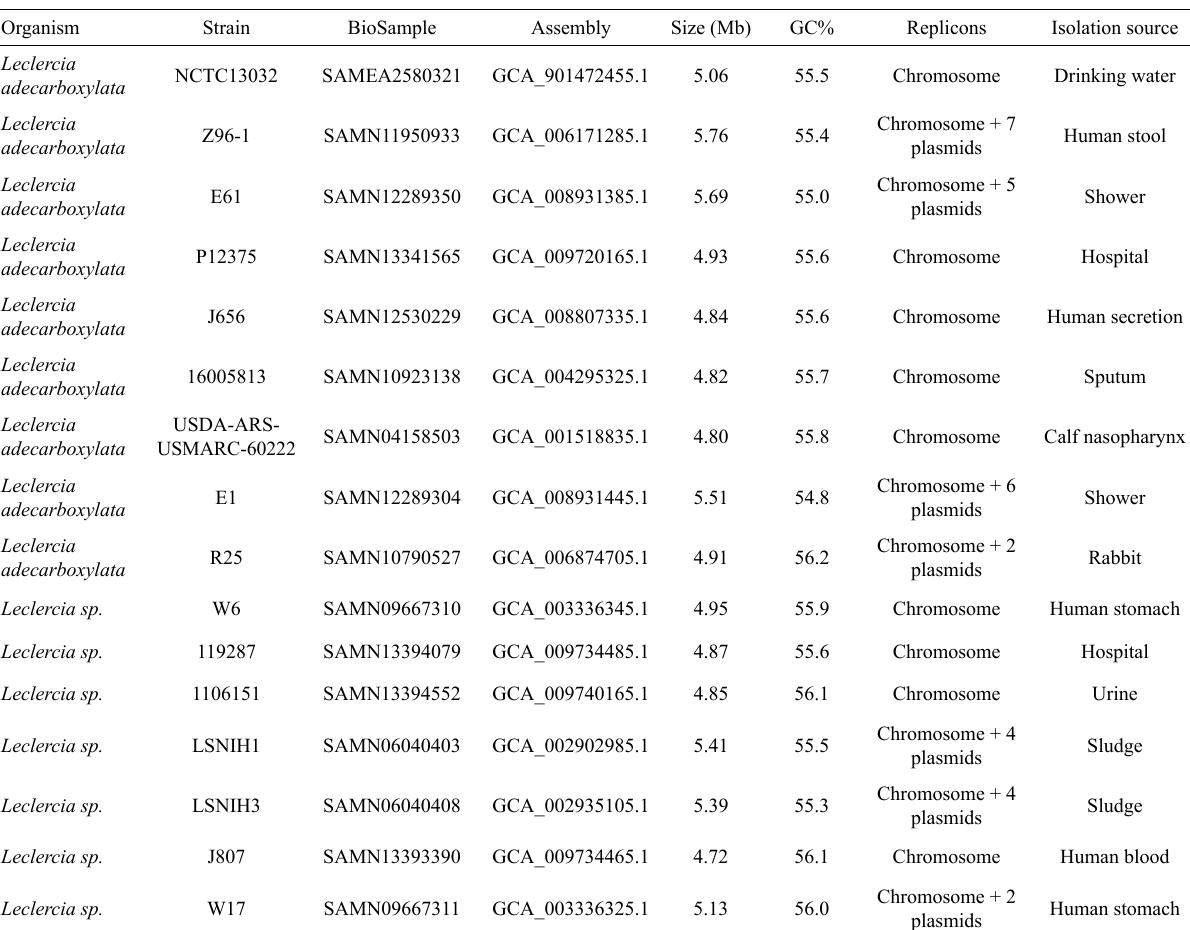
Table 1 – Characteristics of Leclercia strains used in the genomic comparison. Organism Strain BioSample